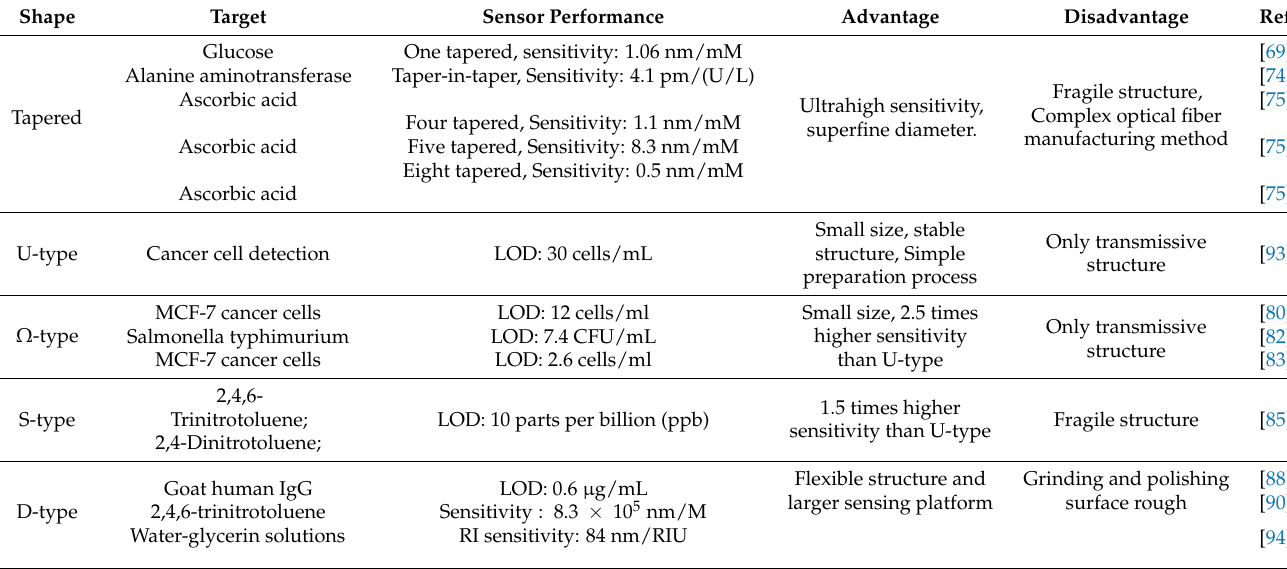
Table 2. The recognition method of the target detection substance of different shapes sensor.